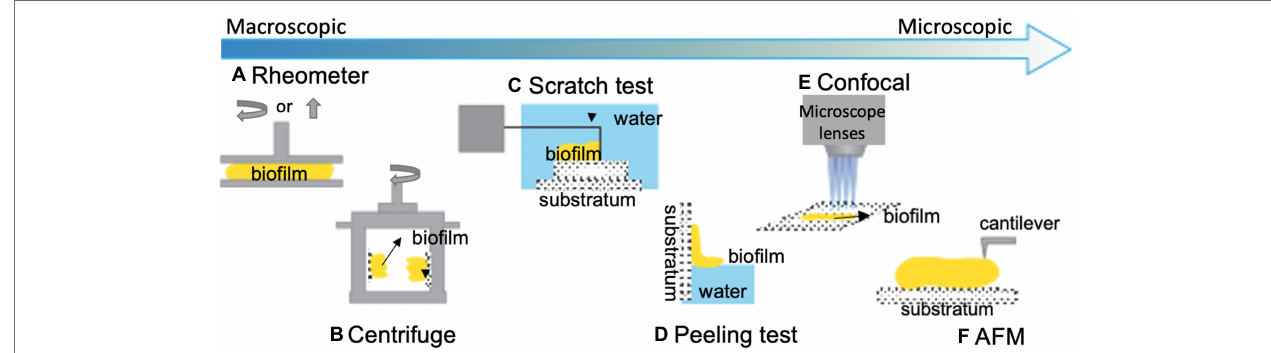
FIGURE 1 | Illustration of some common techniques for quantifying biofilm adhesion. (A) A shear rheometer is used to determine the viscoelastic and adhesive properties of bulk biofilms with different operating modes (Gloag et al., 2018). Yellow represents biofilm. (B) A centrifugal force is applied to biofilm-colonized plates installed on rotary tables to evaluate the biofilm adhesive strength (Ohashi and Harada, 1994). (C) A T-shaped blade is used to scratch biofilms off a surface to measure the energy required to detach a biofilm from the substratum (Chen et al., 1998). (D) A capillary force is used to peel hydrophobic biofilms off of hydrophilic substrates and measure the strength of the biofilm-substrate interaction (Yan et al., 2018). (E) Additionally, confocal-based techniques and (F) AFM-based techniques are commonly utilized for quantifying biofilm adhesion at the cellular scale. This figure is modified with permission from Boudarel et al. (2018).